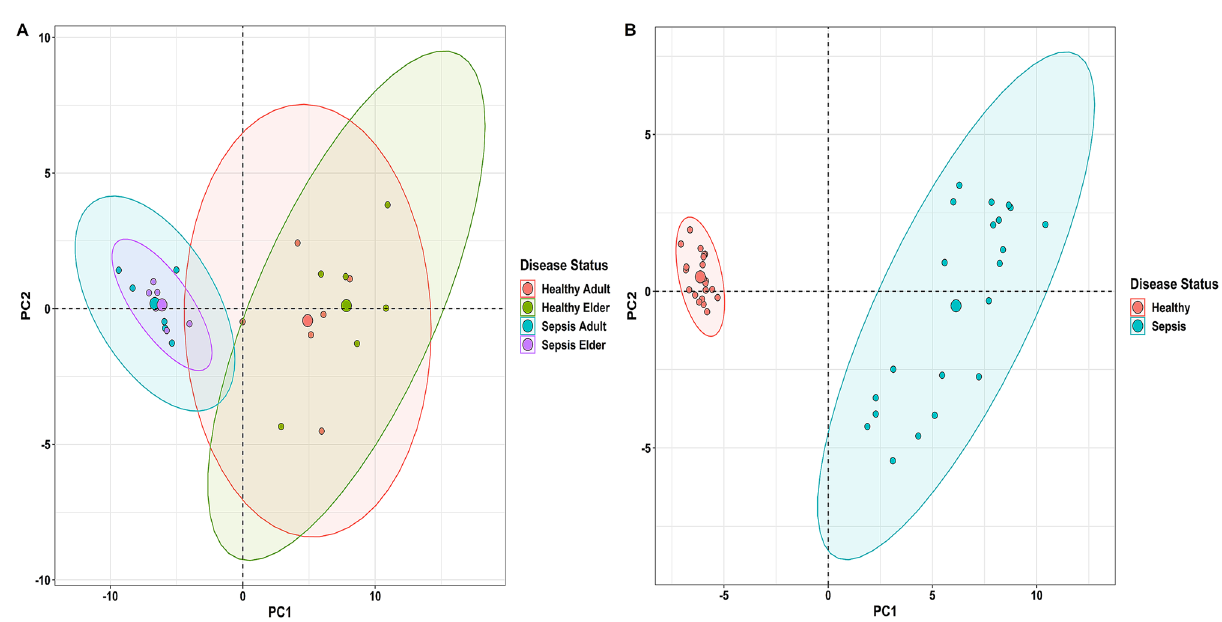
Figure 2. Principal component analysis (PCA) plots showing the expression variability of DEGs across all the samples in (A) GSE67652 and (B) GSE80496 datasets. Each point in the plot signifies the relative expression value of all DEGs dimensionally reduced concerning every sample leading to distinct cluster formations. Healthy adult, healthy elder, sepsis adult, and sepsis elder samples in ( A ) are represented by orange-, green-, cyan-, and magenta-colored points. The orange and cyan colored points represent healthy and sepsis samples in ( B